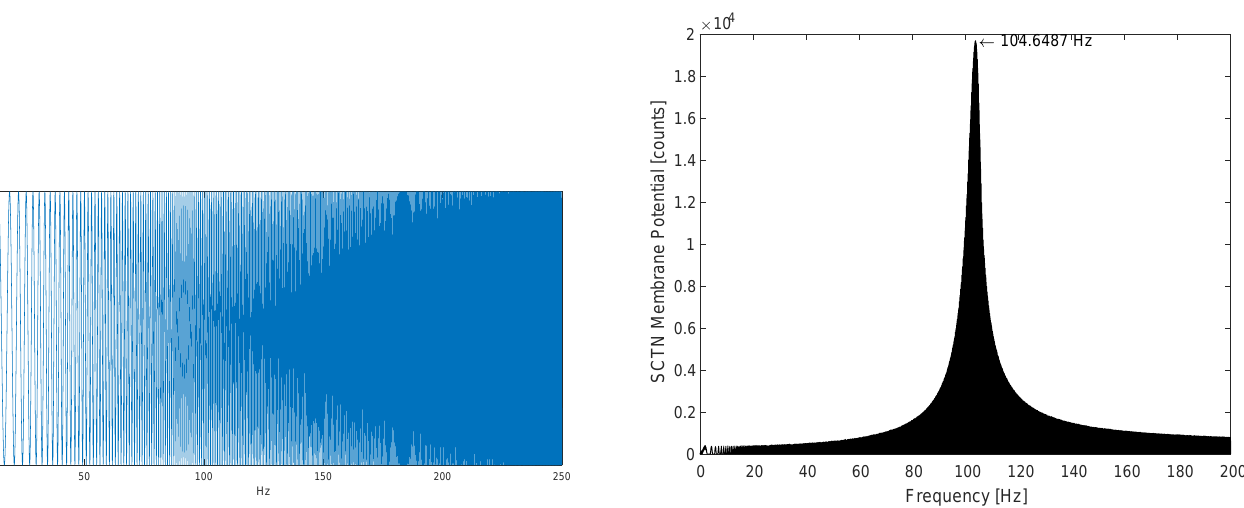
Figure 5. (left) Resonator input: a chirp signal, (right) SCTN-based Resonator output: detected Figure 5. ( left ) Resonator input: a chirp signal. ( right ) SCTN-based Resonator output: detected frequency. frequency. Figure 6 illustrates the simulation results for a bank of 20 resonators (based on SCTN) used to detect 20 different frequencies in the audio spectrum. A chirp signal (in the range of 20 to 20k Hz) has been used as an input to each of the 20 resonators. The array of resonators was tuned to detect the following frequencies: [155; 304; 480; 703; 937; 1242; 1593; 2015;